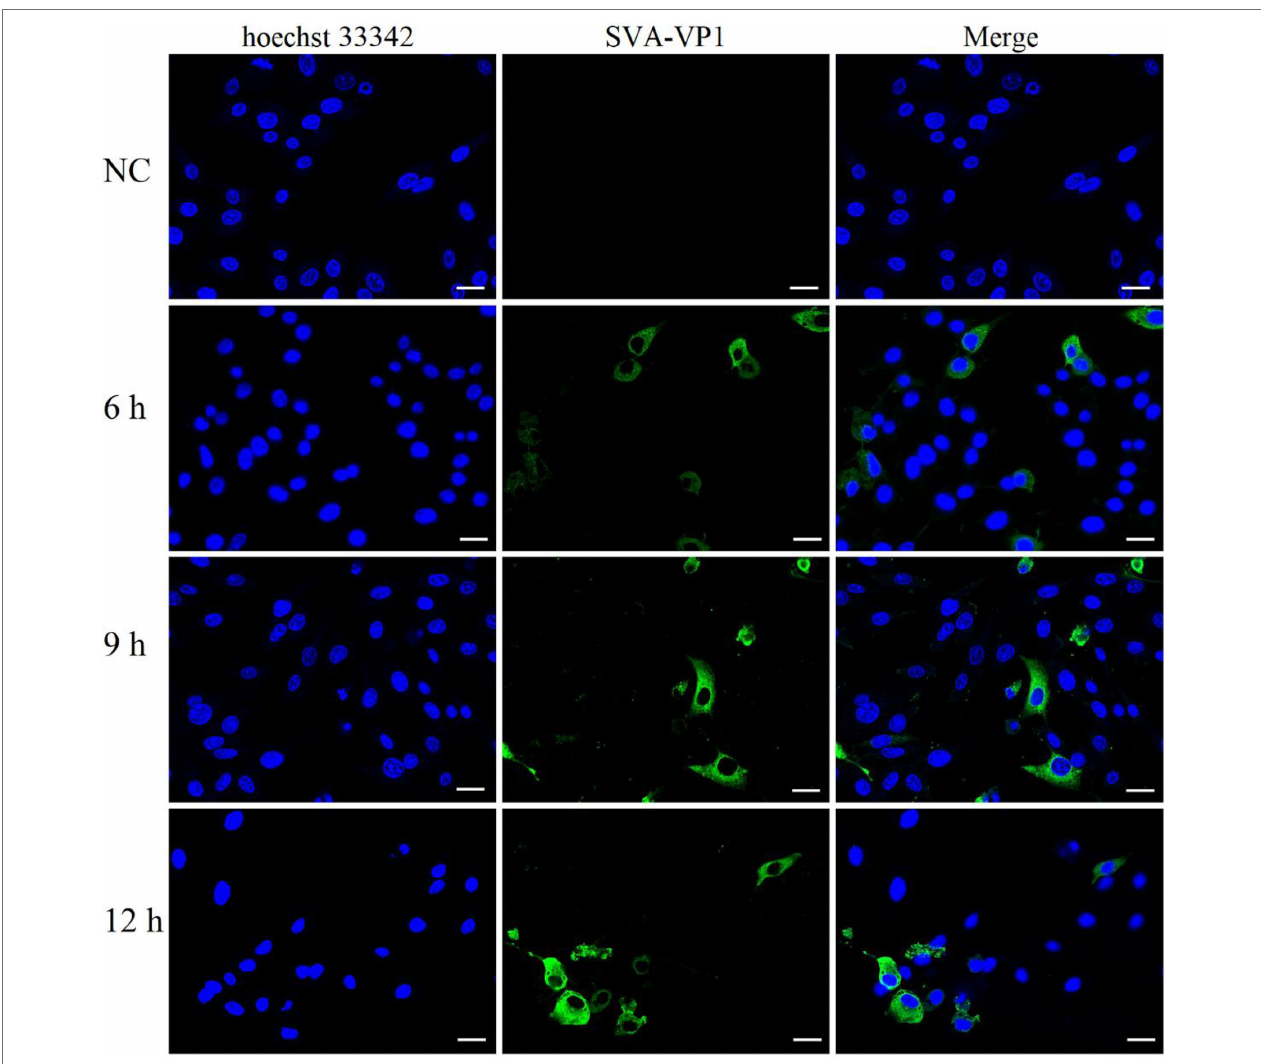
FIGURE 1 | Indirect immunofluorescence analysis of IBRS-2 cells infected with Senecavirus A (SVA). The cells were detected for indirect immunofluorescence assays with the rabbit anti-SVA VP1 antibodies (green), and nuclei were counterstained with 10 μ g/ml hoechst33342 (blue). Fluorescent images were acquired with a confocal laser scanning microscope. Bright field, Scale bar = 25 μ